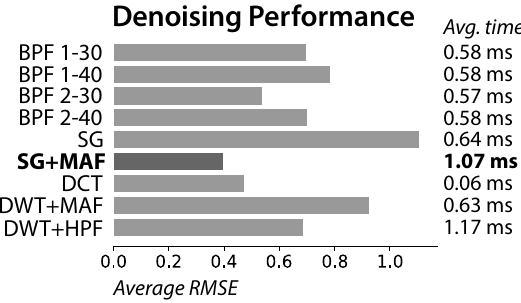
Figure 3. Root mean square error between the clean simulated signals and their versions after contamination with expected noise and denoising with each method. The times required to perform the denoising are also presented.